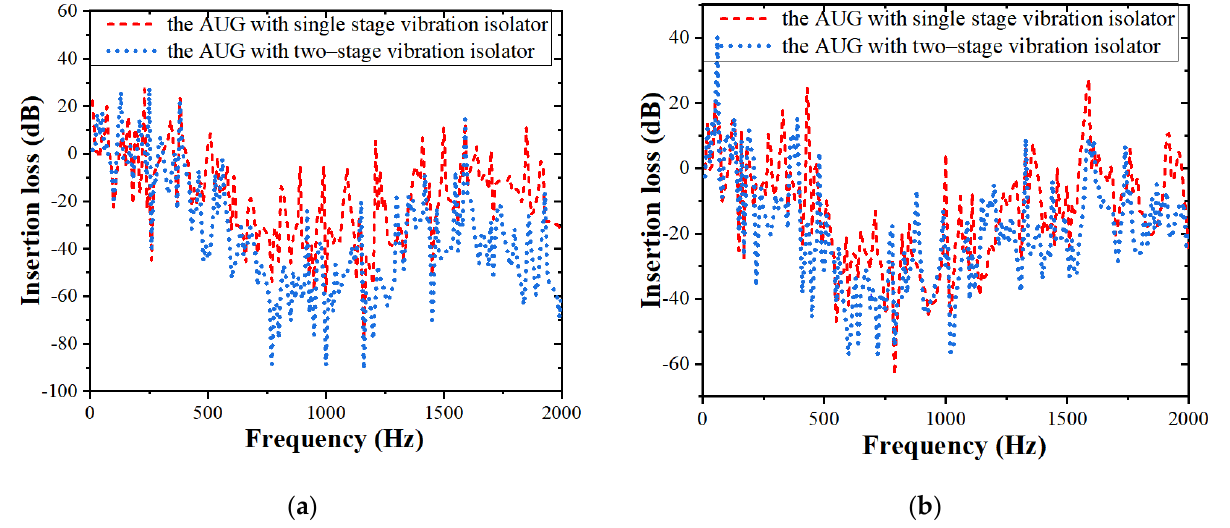
Figure 17. The insertion loss of the AUG with single- and two-stage vibration isolation in ( a ) air and ( b ) water . ( b )